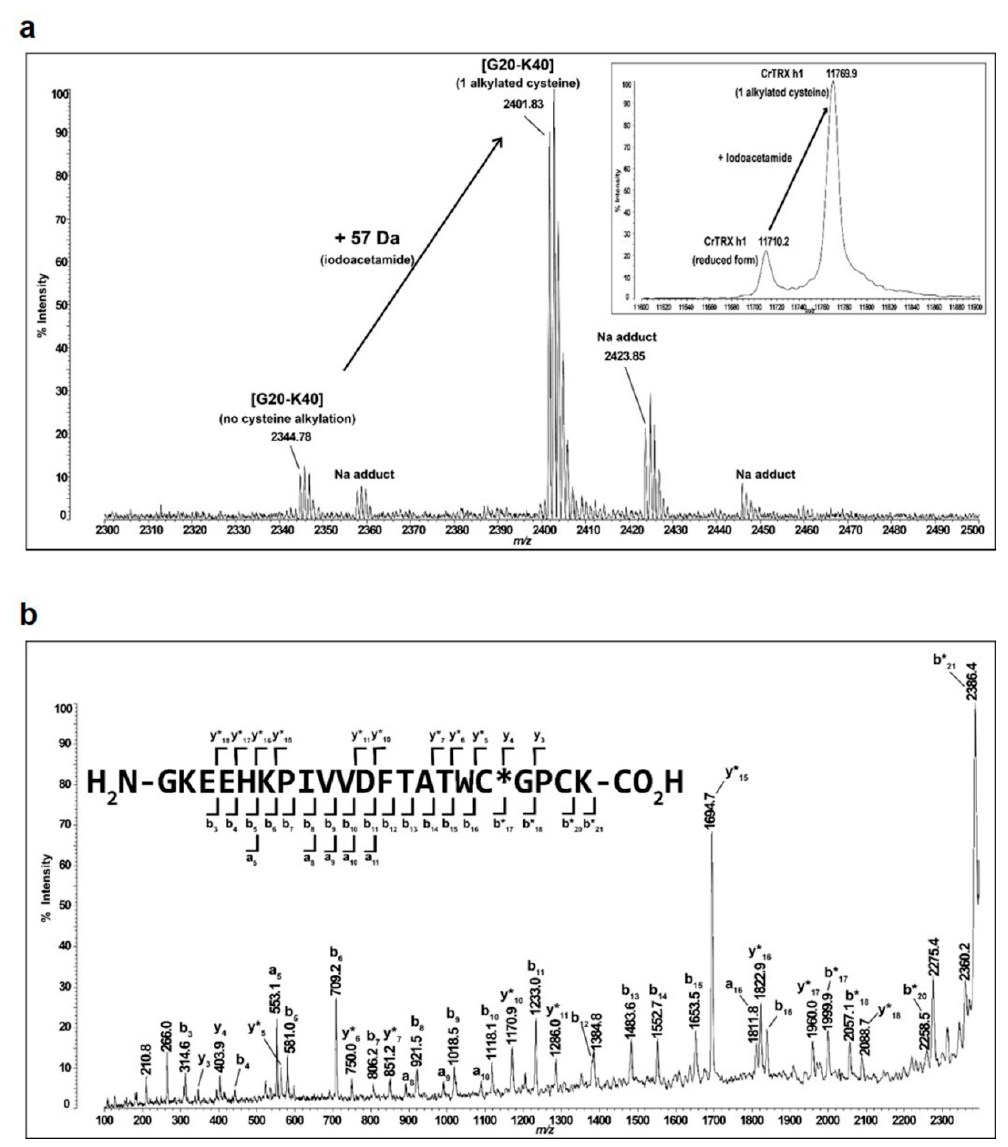
Figure 6. Mass spectrometry analysis of monoalkylated CrTRXh1. ( a ) Matrix-assisted laser desorption/ionization time-of-flight (MALDI-TOF) spectrum after tryptic digestion was determined for reduced CrTRXh1 after treatment with 2-fold molar excess of IAM at pH 7.1 (incubation time: 105 s). The active site containing peptide (Gly20–Lys40) is indicated (experimental mass of 2344.78 Da). The 57 Da shift after treatment with iodoacetamide (IAM) indicates monoalkylation of CrTRXh1 (experimental